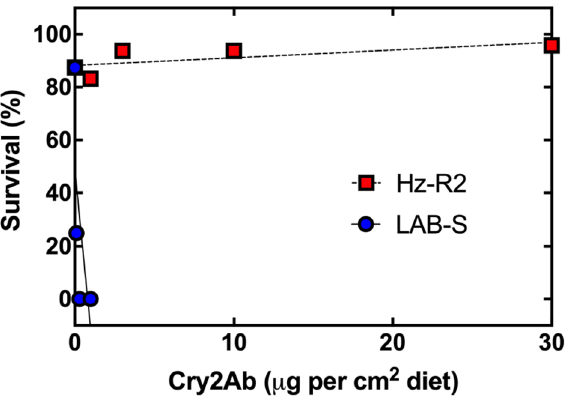
Figure 1. Susceptibility to Cry2Ab of CRISPR-edited strain Hz-R2 and its parent susceptible strain LAB-S of H. zea . Each point represents mean survival (n = 48 per